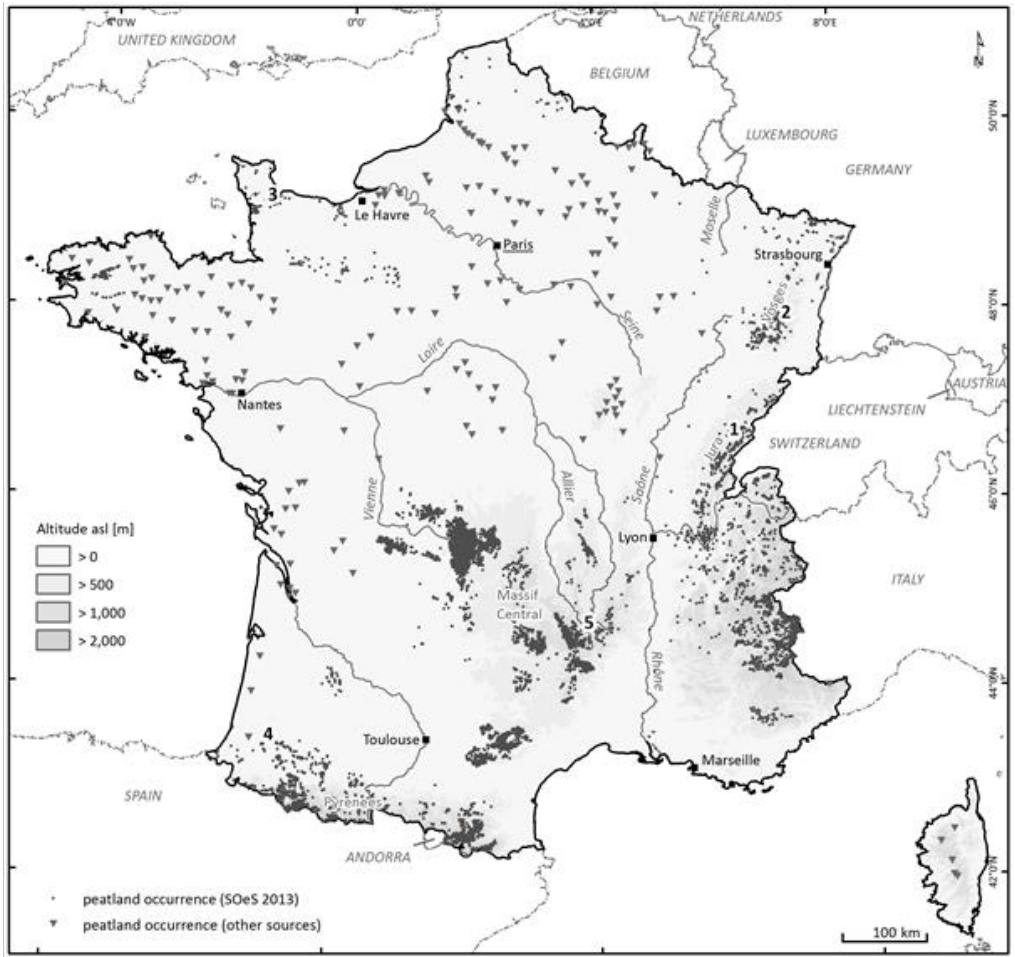
Figure 1. Map of current peatland distribution and locations of peatland areas of international importance in France. Dots indicate information from SOeS (2013). Triangles indicate information from various other sources compiled by Pôle-relais tourbières. In both cases, peatlands with characteristic vegetation are depicted, regardless of whether peat is currently being formed. Peatlands without characteristic vegetation ( e.g . heavily drained peatlands) are included only for the following regions: 1 = Drugeon valley, 2 = Tourbière du Tanet, 3 = Tourbière de Baupte, 4 = Les Mées, 5 = Tourbière de Ribains. Significant mire areas in Guiana (Marais de Kaw) and the French Southern and Antarctic Territories (Ile d’Amsterdam,